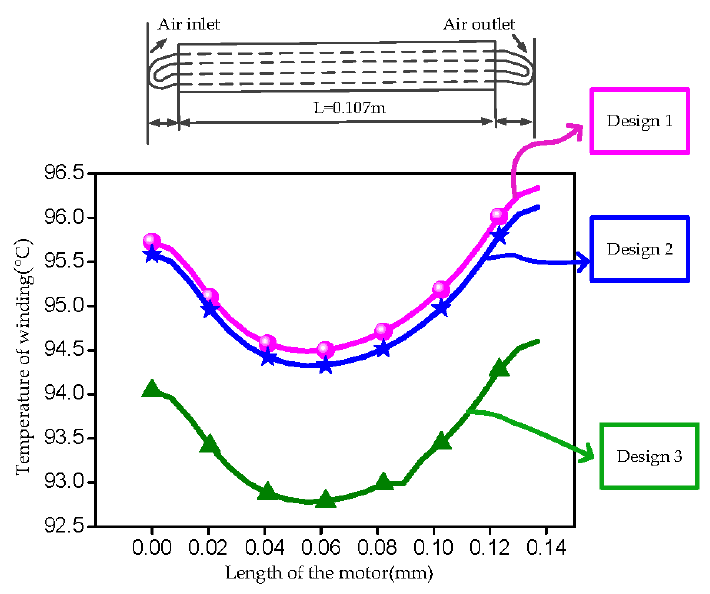
Figure 9. Temperature distribution of stator winding under three designs.